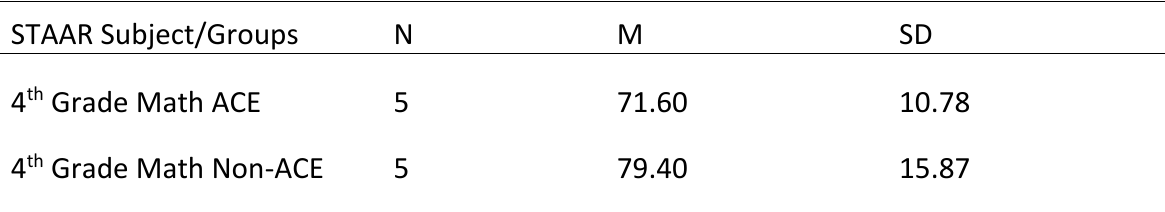
Table 5 : Means and Standard Deviations: Student performance in 4 th Grade STAAR Math STAAR Subject/Groups N M